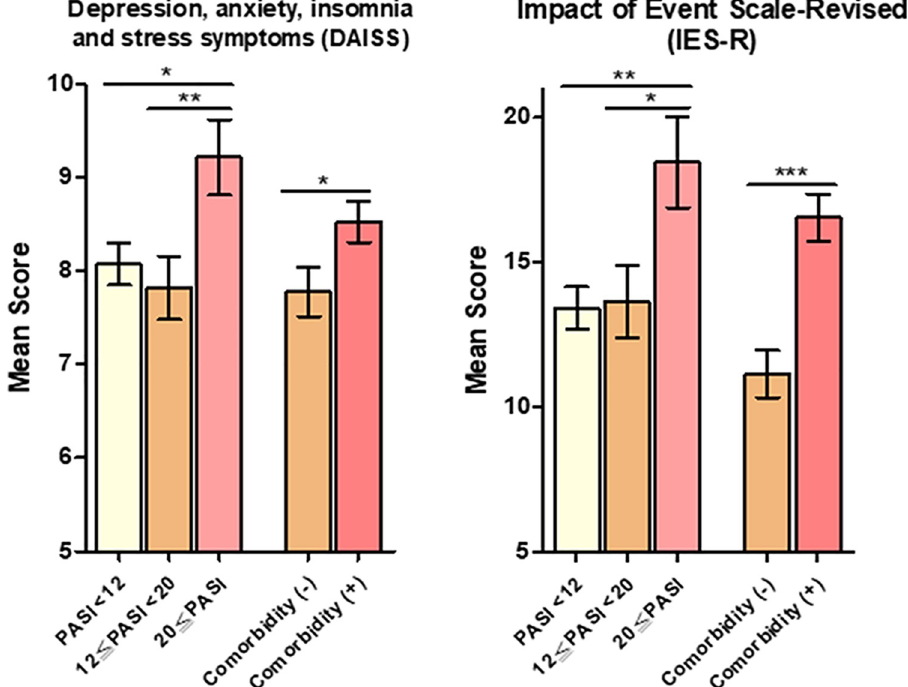
Fig 2. Psychological impact of the COVID-19 pandemic. Comparison of scores from the IES-R and a scale measuring DAISS between psoriasis patients who were stratified by psoriasis severity and comorbidity. PASI, Psoriasis Area, and Severity Index. � P < 0.05; �� P < 0.01, ��� P < 0.001. Comparisons between groups stratified by PASI and comorbidity were performed using the Kruskal–Wallis test and the Mann–Whitney U test, respectively.